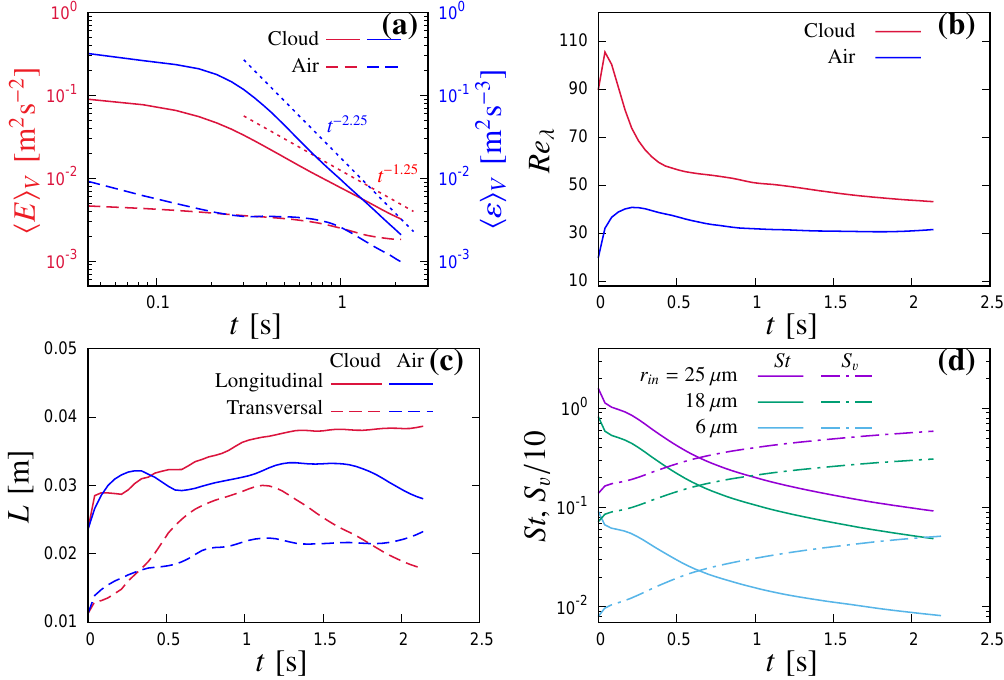
Figure 2. Transient evolution of the flow inside the clear air and cloudy region: ( a ) decay of TKE E and dissipation rate ε ; ( b ) Taylor micro-scale Reynolds number Re λ ; ( c ) longitudinal and transversal integral length scales L ; and ( d ) average cloud droplet Stokes number St and settling parameter S v of the different droplet populations. Plots ( a – c ) are from simulation R25 . Differences are small among the three